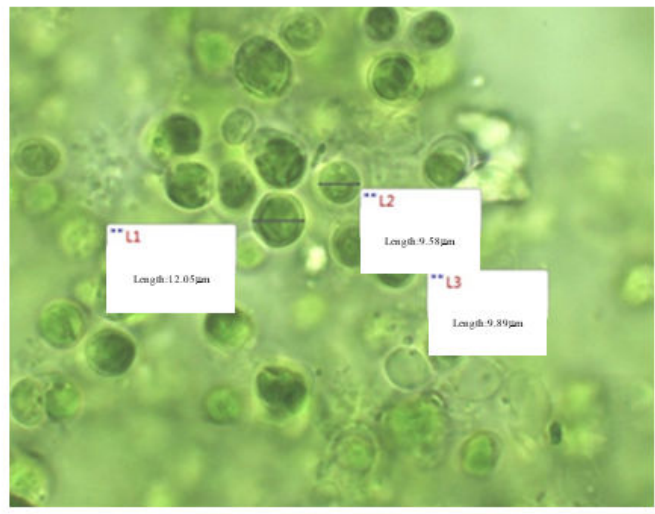
Figure 9. Measurement of the diameter of cultured cells on the 20th day. Source: own